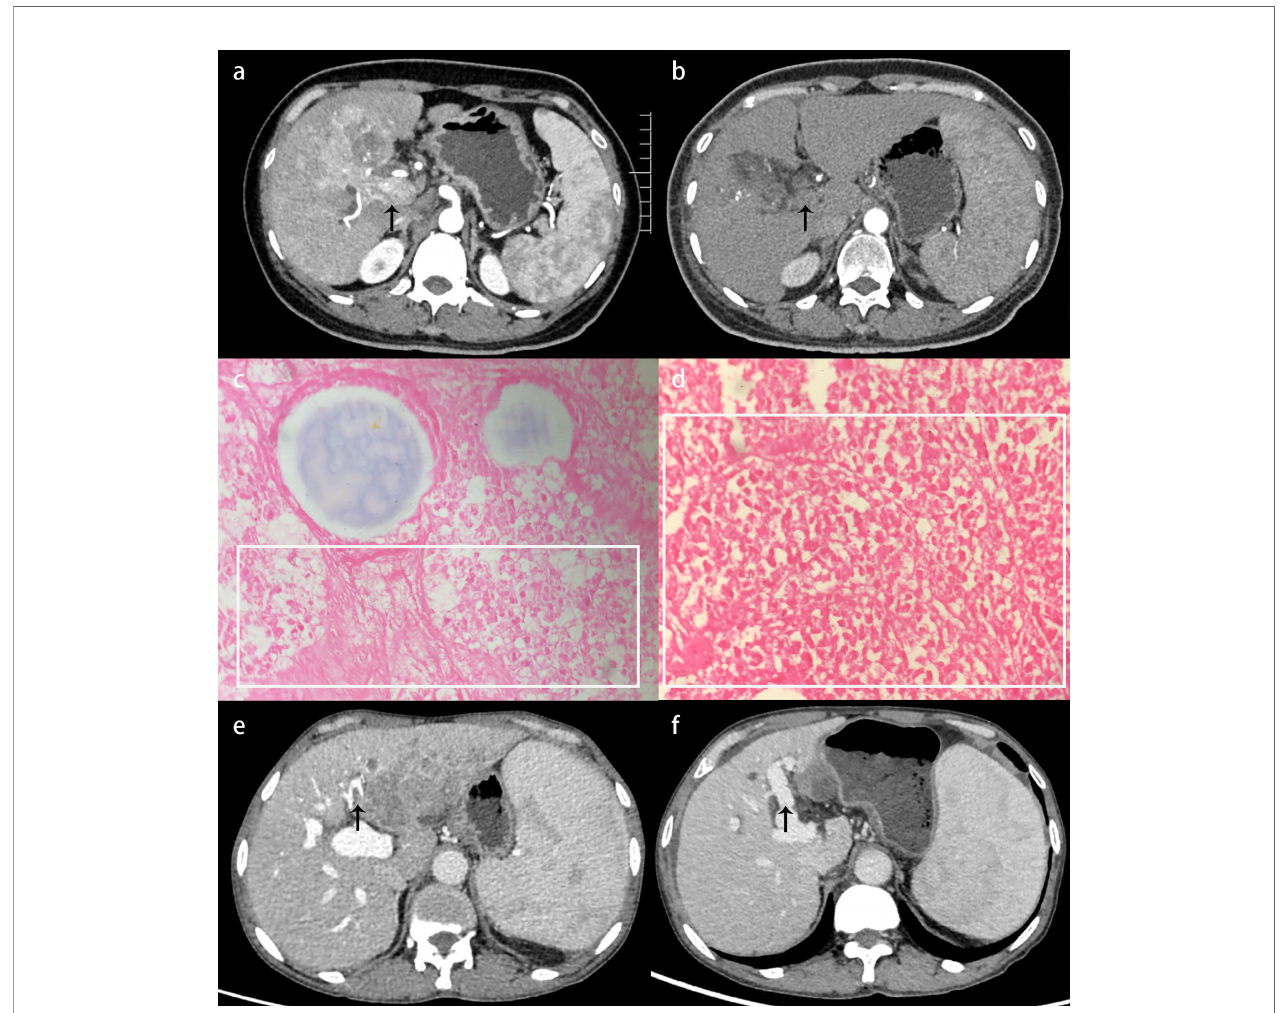
FIGURE 2 | Presentation of two downstaged patients with HCC. (A) Before administering the combination therapy, contrast-enhanced CT exhibited tumor thrombus in the main trunk of the portal vein with enhancement during the arterial phase (black arrow). (B) After 4.5 months of the combination therapy, contrast- enhanced CT exhibited shrunken tumor size and necrotic tumor tissues in the portal vein without enhancement (black arrow). (C) Pathological examination con fi rmed HCC with massive necrosis (×400); the necrotic region is shown in a white rectangle. (D) Pathological examination con fi rmed that the PVTT was completely necrotic (×400); the necrotic region is shown in a white rectangle. (E) Contrast-enhanced CT showed tumor thrombus in the left main trunk of the portal vein with enhancement during the portal venous phase (black arrow). (F) After 6.5 months of the combination therapy, contrast-enhanced CT showed shrunken tumor size and absence of PVTT (black arrow). CT, Computed tomography; HCC, hepatocellular carcinoma; PVTT, portal vein tumor